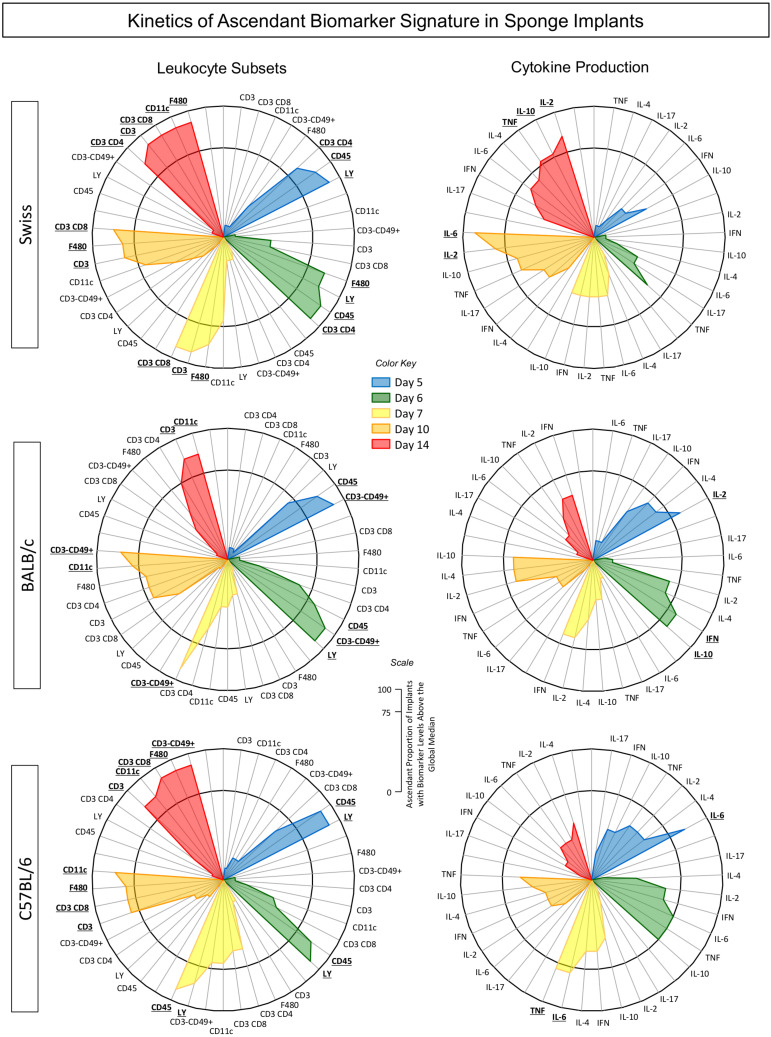
Kinetics of ascendant biomarker signature in sponge implants. The sponge disks were subcutaneously implanted and removed at Day5, Day6, Day7, Day10, and Day14 post-implant. They were gently squeezed and cell suspension stained for selective quantification of leukocytes subsets by Flow Cytometry. In parallel experiments, the sponge implants were homogenized for measurement of cytokine production by Cytometric Bead Array. Data are reported as biomarker signature according to Luiza-Silva et al. (2011). The biomarker signatures were determined using the frequency of biomarker level above the global median cut-off defined for each biomarker. The data of biomarkers displayed in the Figure show the frequency of those presenting high levels (above the global median cut-off). Radar charts were used to compile and summarize the ascendant proportion of implants with biomarker levels above the global median for each cell subset (CD45+, Ly+, F4/80+, CD11c+, CD3–CD49+, CD3+, CD3+CD4+, and CD3+CD8+) as well as each soluble cytokine (IL-6, TNF, IL-2, IFN-γ, IL-4, IL-10, and IL-17), at different time-points post-implant [Day5 (blue), Day6 (green), Day7 (yellow), Day10 (orange), and Day14 (red)] for Swiss, BALB/c, and C57BL/6 mice. The biomarkers with frequencies above the 75th percentile were considered relevant and highlighted in bold underline format.